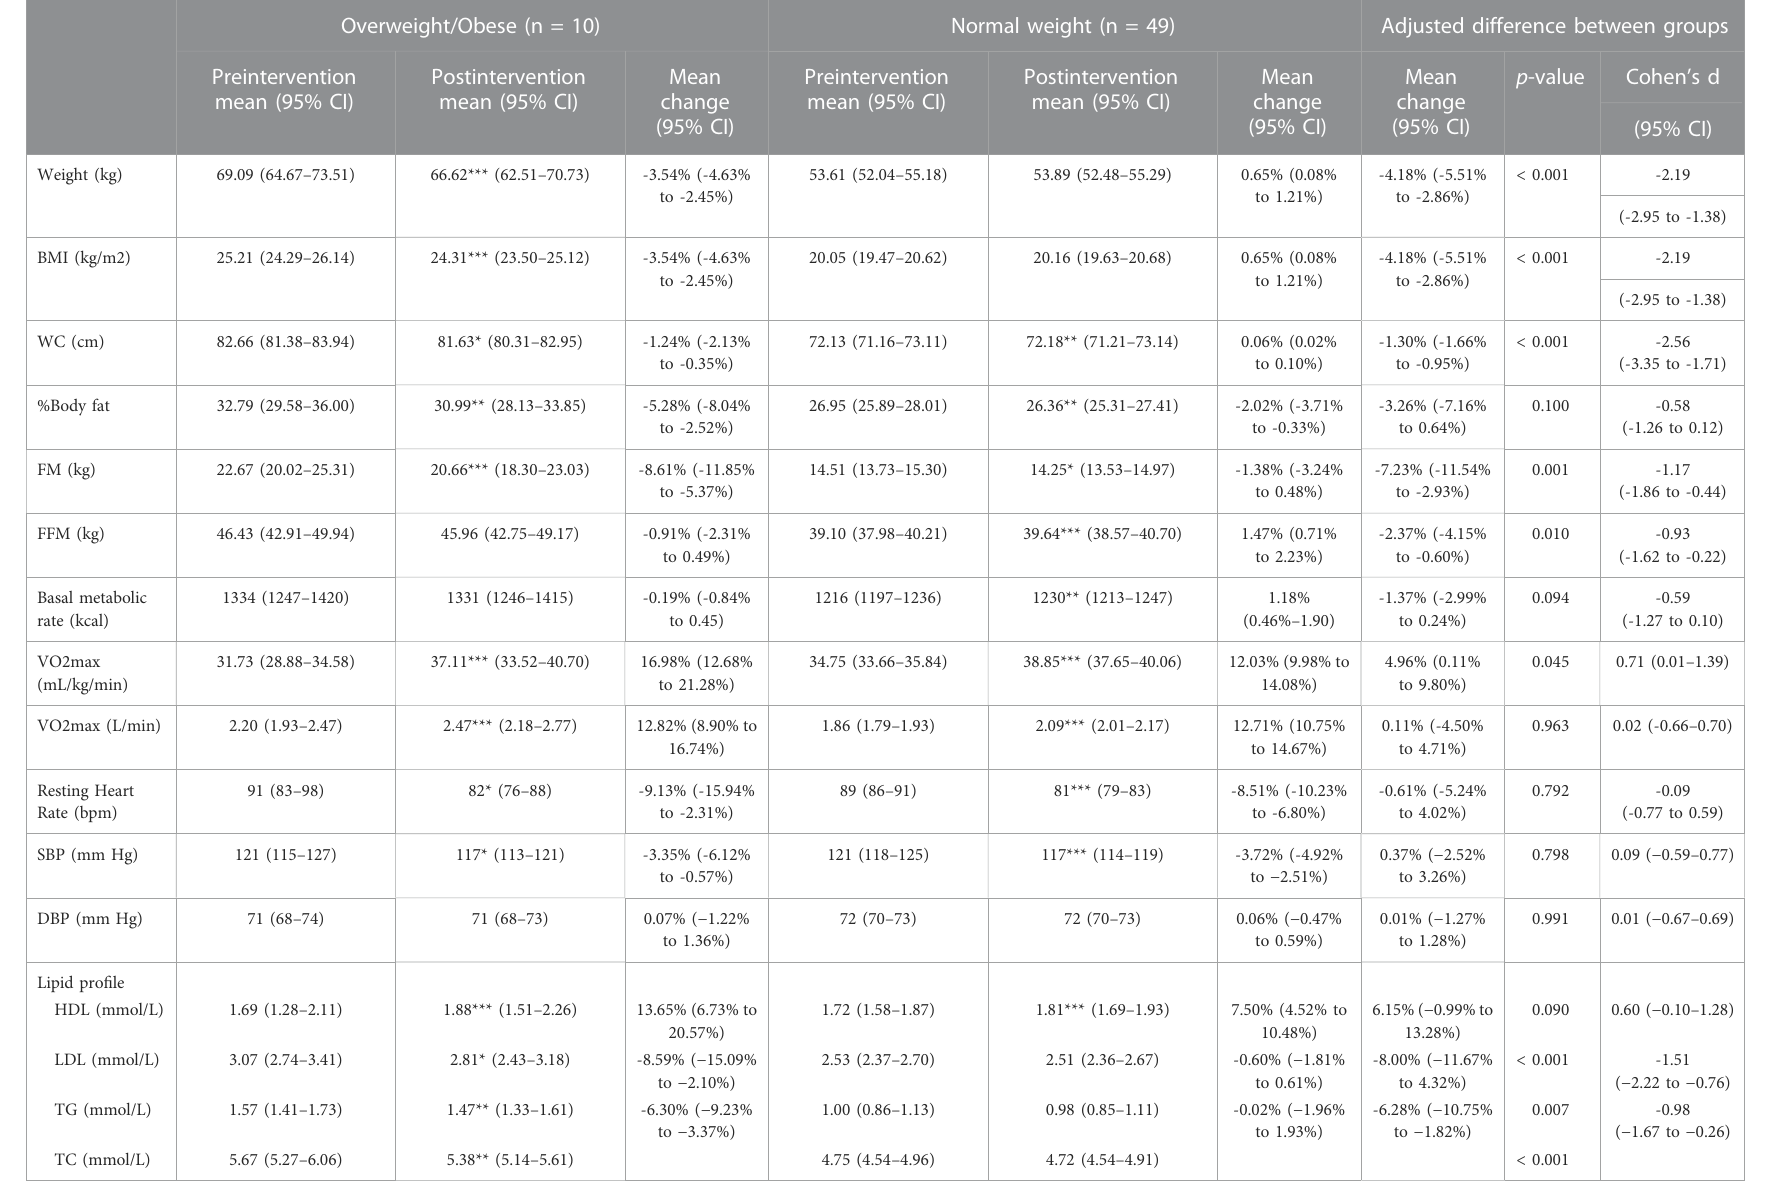
TABLE 3 The effects of the Tabata style functional HIIT between overweight/obese and normal weight